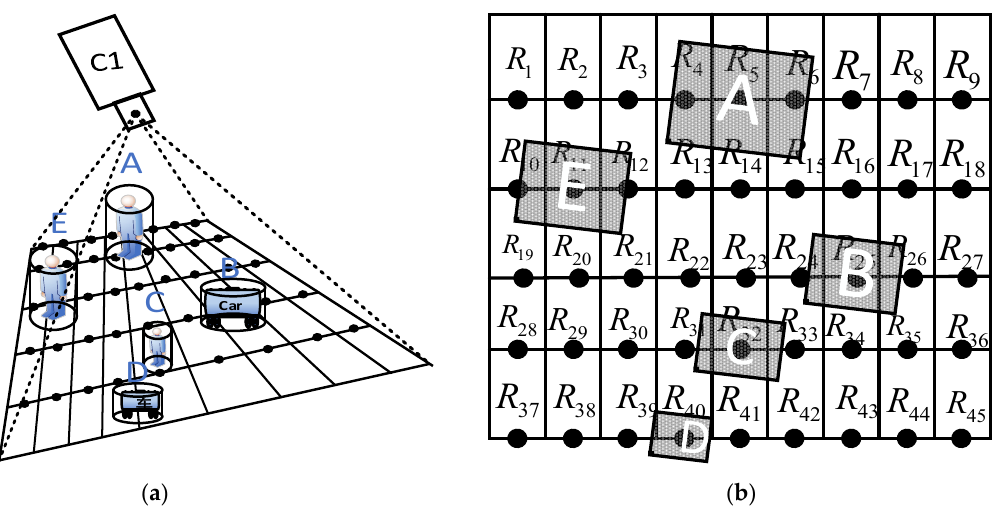
Figure 6. Design of adaptive threshold target-detection method (taking A, B, etc. as examples): Object in ( a ) geographical space and ( b ) in image space.